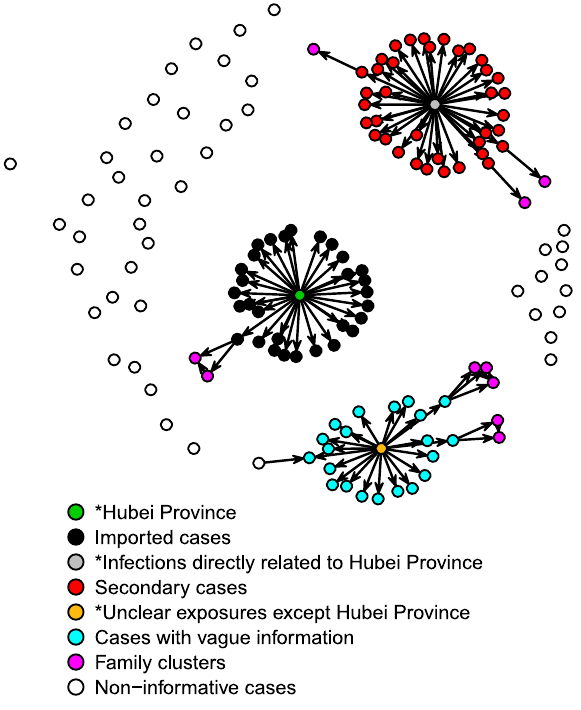
Figure 2. Transmission network graph for confirmed COVID-19 cases in